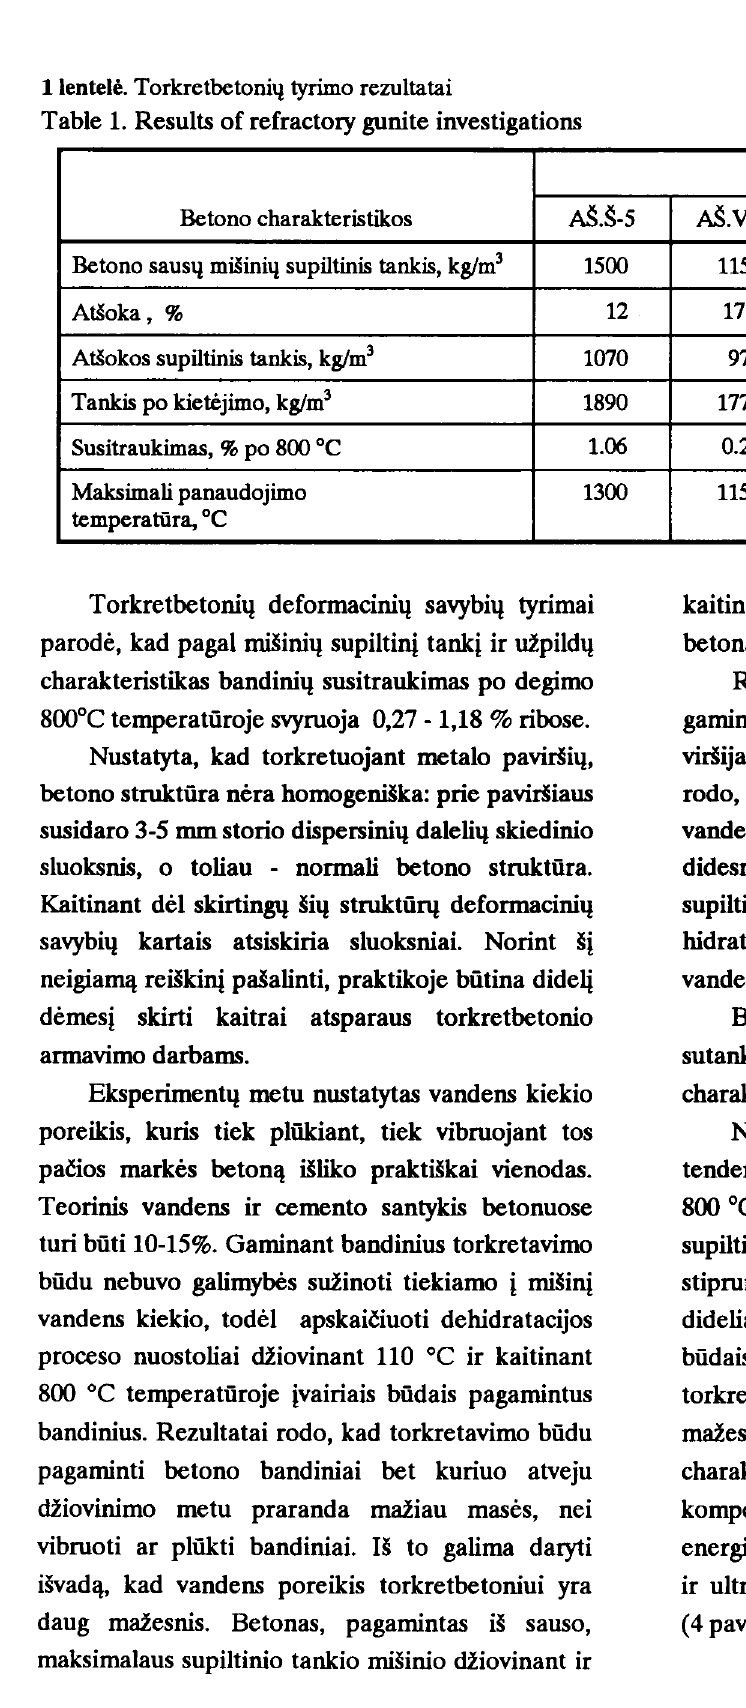
Table 1. Results of refractory gunite